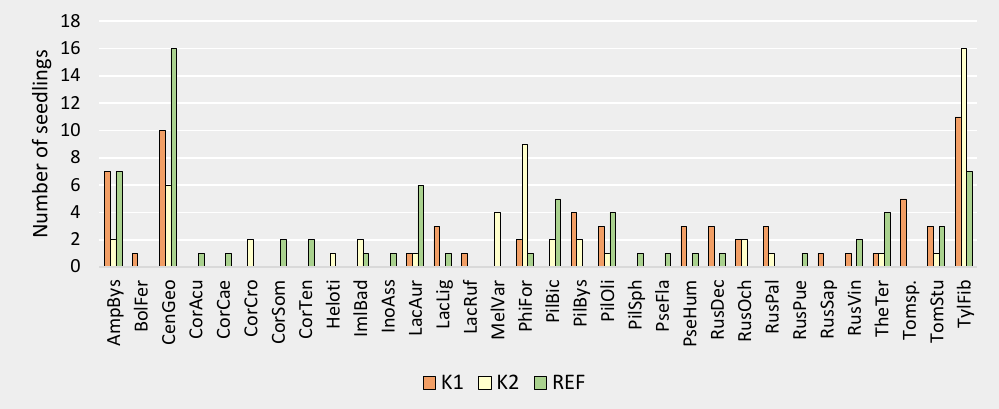
Figure 4. ECM species occurrence on Norway spruce seedlings. K1—forest attacked by bark beetle;